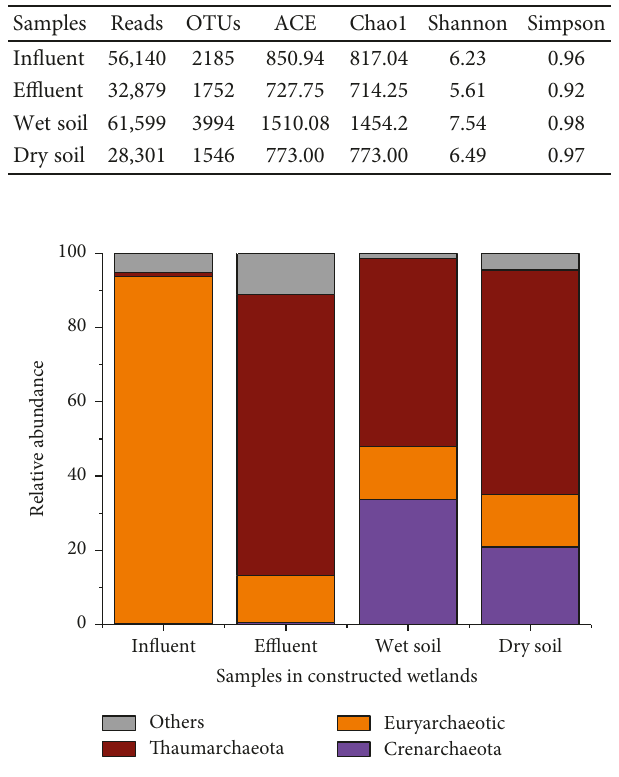
Figure 6: Archaeal relative abundance of four samples in phyla in constructed wetlands.